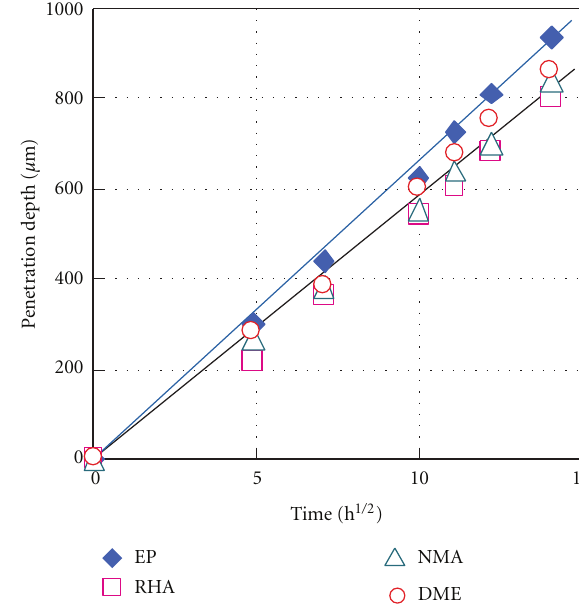
Figure 9: Penetration depth of neat epoxy and epoxy/organoclay nanocomposite under di ff erent mixing methods in terms of square root of